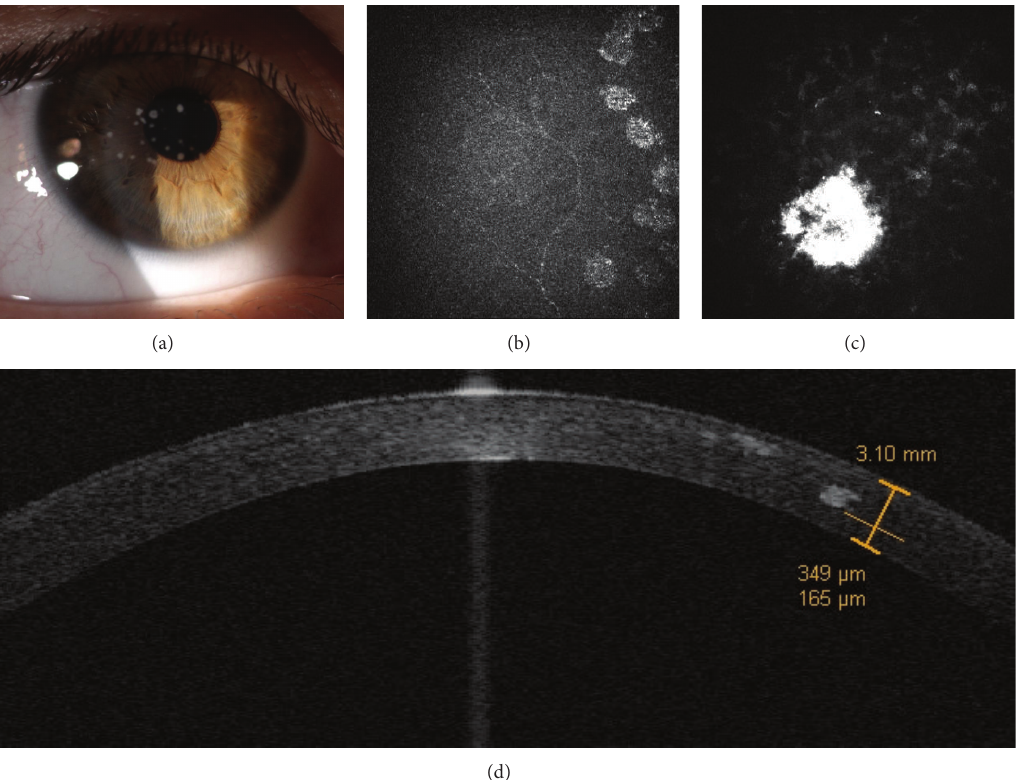
Figure 2: Case 1 , the daughter. Slit-lamp examination shows the presence of white patchy stromal opacities, without stellate and linear opacities (a). IVCM reveals necklace-shaped opacities surrounding the subepithelial nerve fibers and deep dense granular deposits (b and c). Time domain OCT corneal scan reveals the topographic localization and the depth of corneal deposits (d).